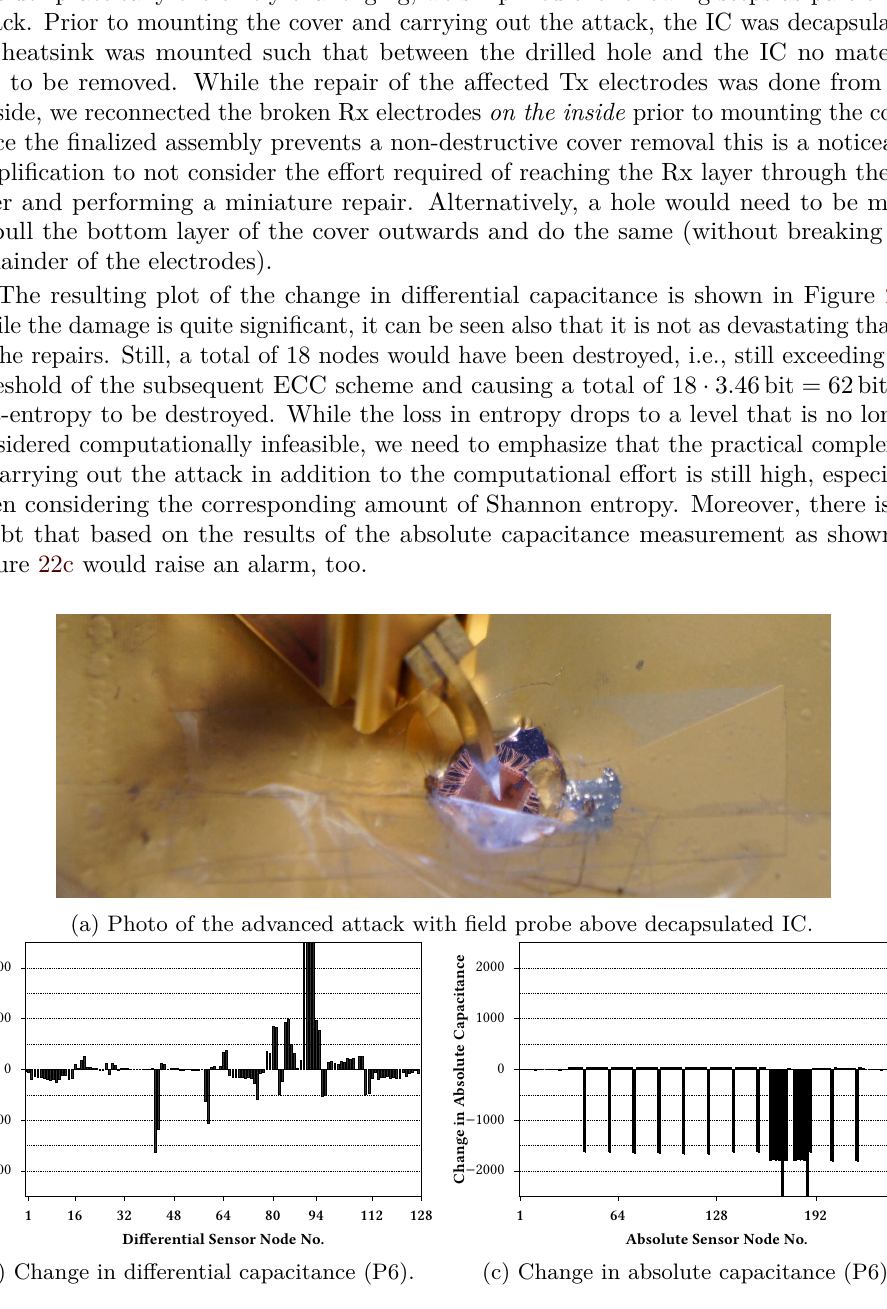
Figure 22: Attack Profile 6 (P6): Using drill of 5 mm with subsequent Tx and Rx repair. Attack Profile 7 (P7): Advanced Attack with Attempted Repair. We